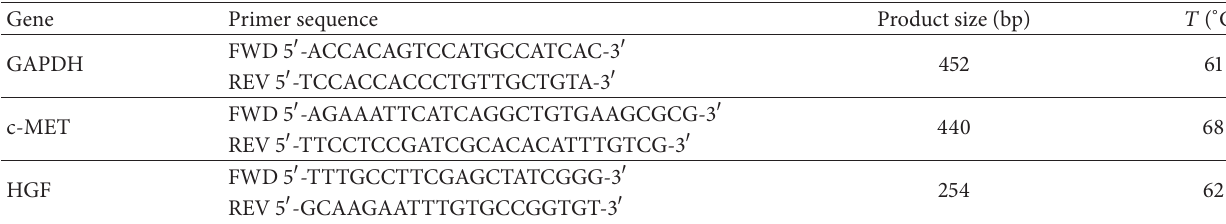
Table 1: List of primers used for RT-PCR in